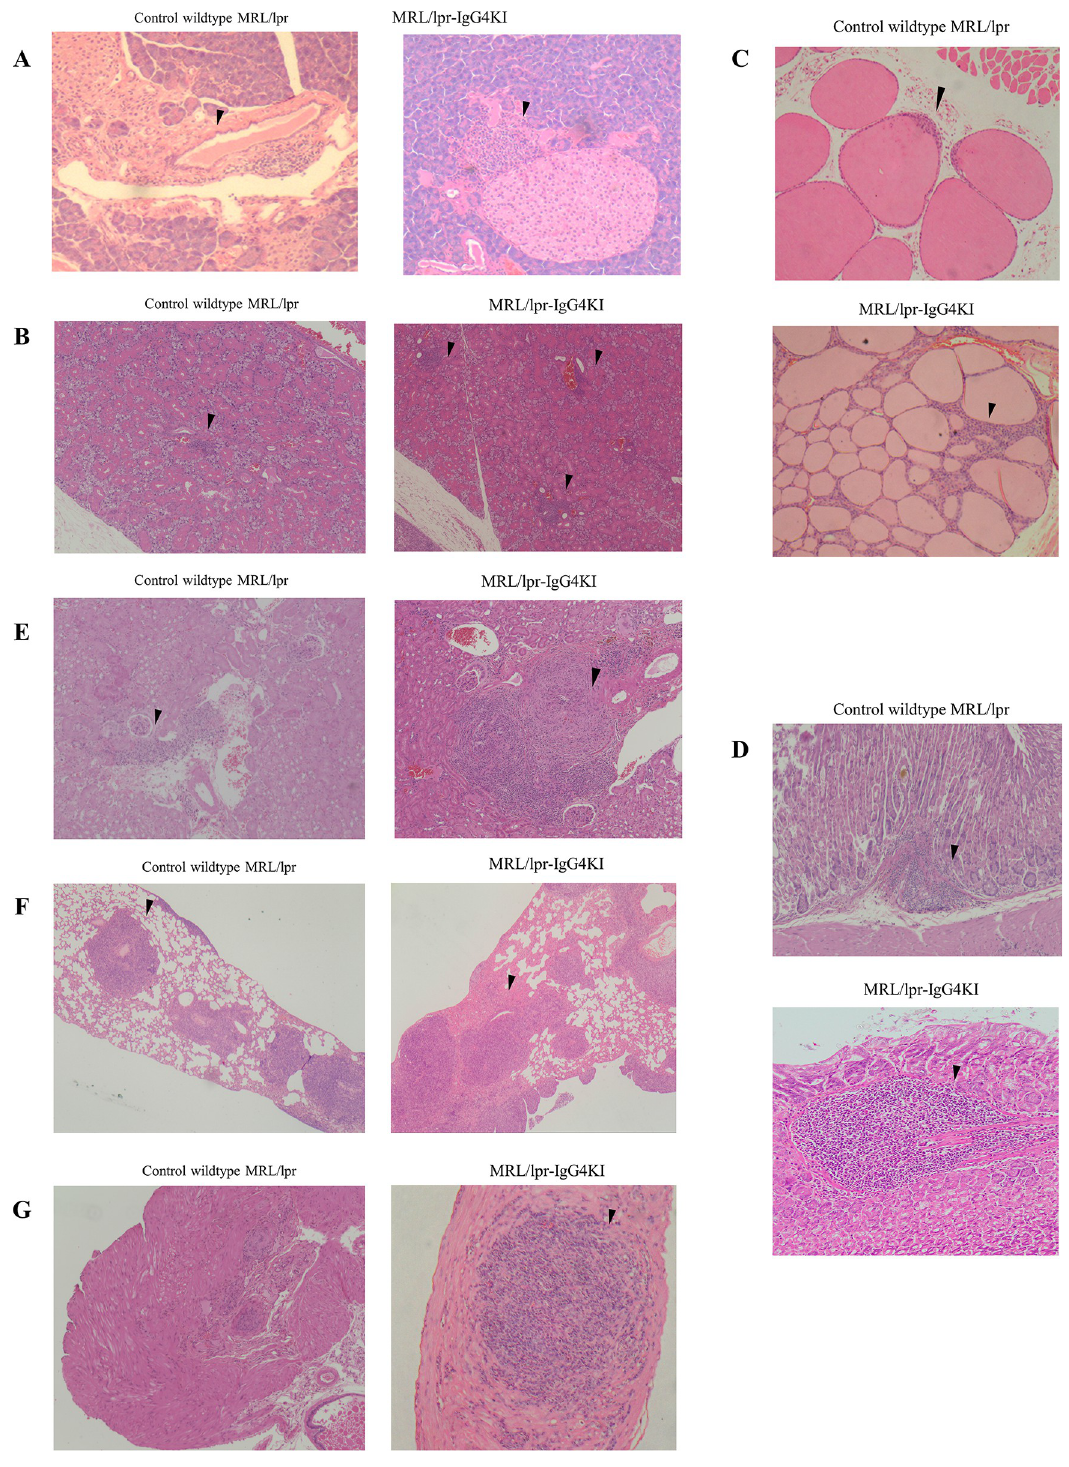
Fig 3. Hematoxylin and eosin (H&E)-stained tissue sections in MRL/lpr-hIgG4KI homozygous mice. A. Marked inflammatory cell infiltration around blood vessels and, partially, inflammatory cell infiltration around islets of the pancreas. B. Diffuse inflammatory cell infiltration in the salivary gland. C. Diffuse inflammatory cell infiltration around follicles of the thyroid gland. D. Prominent inflammatory cell infiltration in submucosa of the stomach. E. Marked perivascular inflammatory cell infiltration in the kidney. F. Marked perivascular inflammatory cell infiltration in the lung. G. Marked inflammatory cell infiltration in the prostate gland.